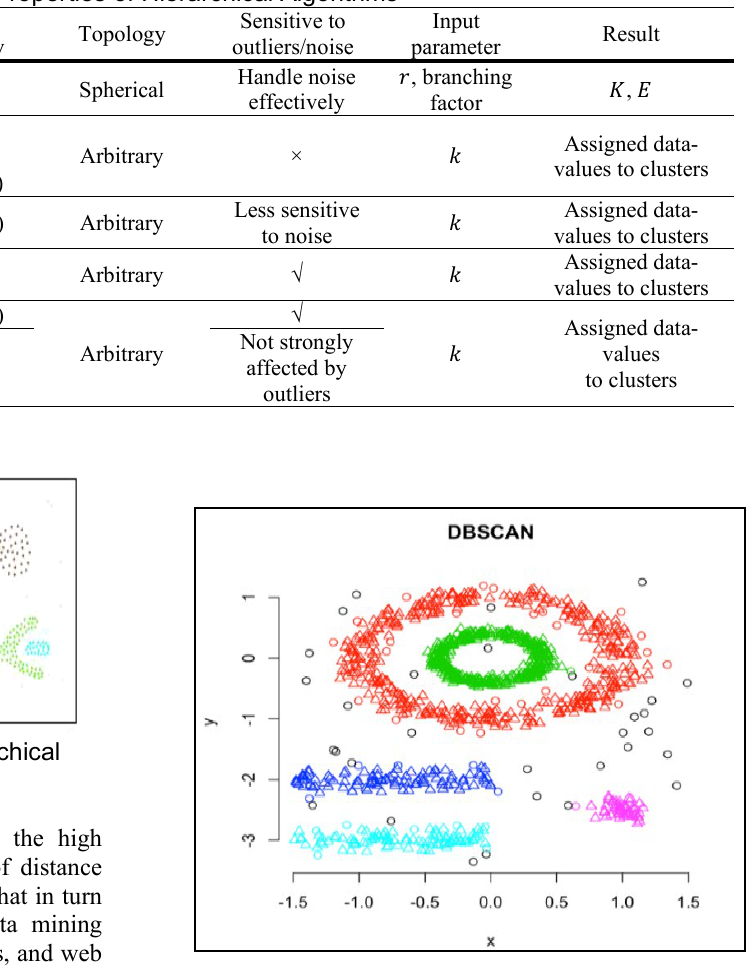
Figure 6. Clusters produced from Density based algorithm